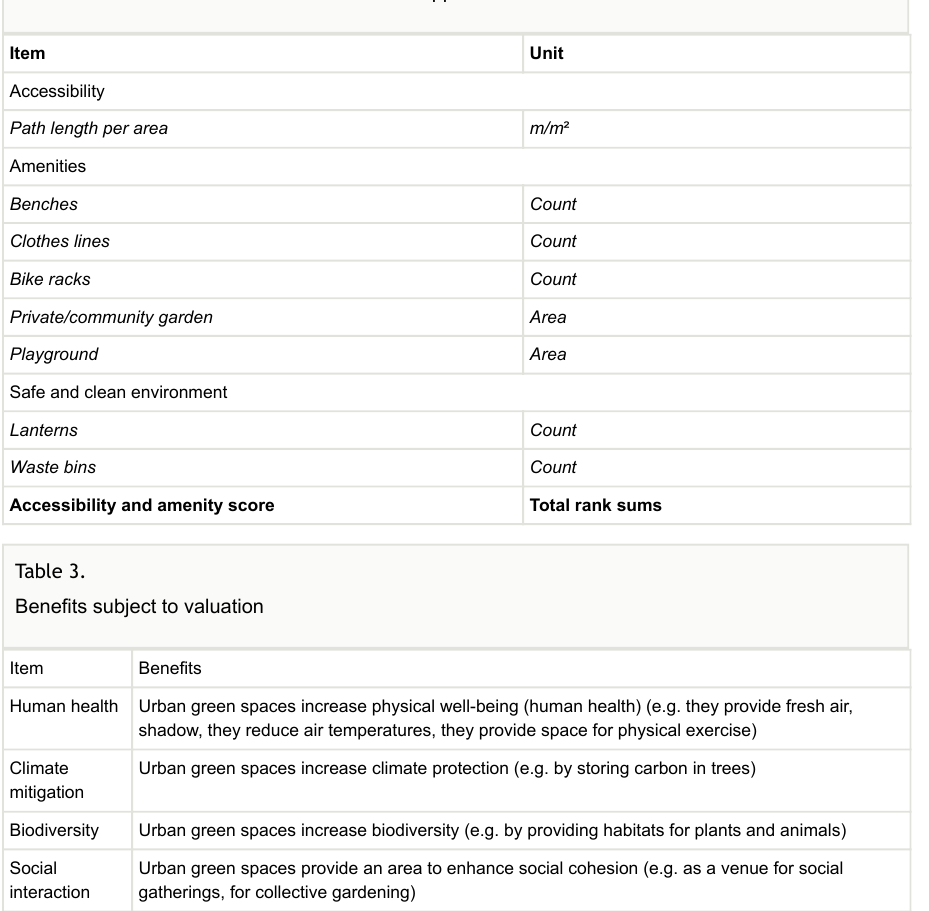
Items for the assessment of social interaction opportunities.